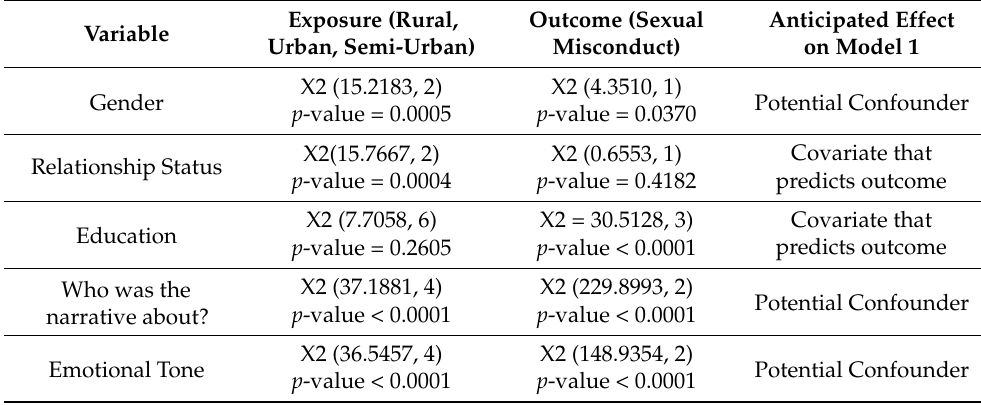
Table A1. Bivariate Analyses Objective